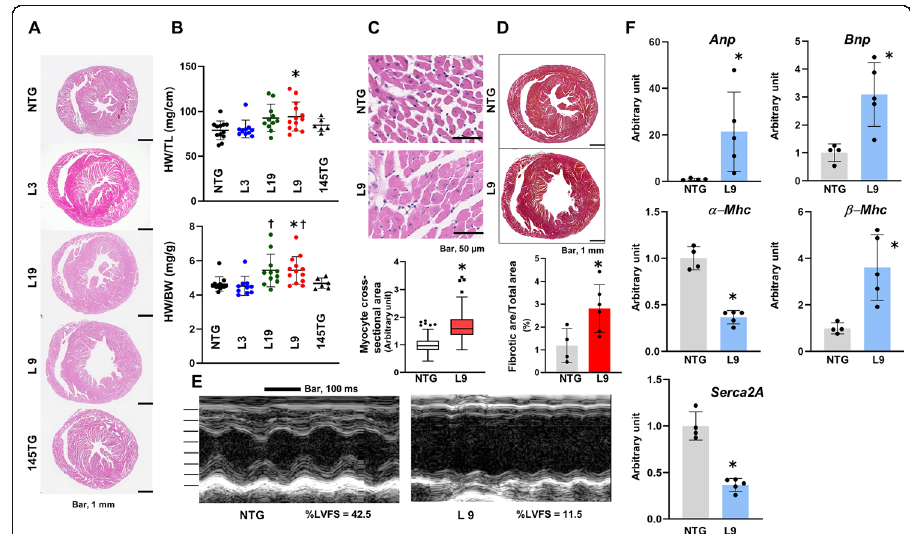
Fig. 2 Characterization of the hearts in α MHC/miR-143/145TG and α MHC/miR-145TG mice. a Macroscopic histological analysis of hematoxylin & eosin-stained hearts of 4-month old male α MHC/miR-143/145TG and α MHC/miR-145 TG mice. b Heart weight corrected for tibia length (upper panel) or body weight (lower panel) of male α MHC/miR-143/145TG and α MHC/miR-145TG mice. The results are presented as the means ± SD with scattered blots. Significance was assessed with one-way ANOVA followed by a post hoc Tukey test ( n = 6 ~ 13; * p < 0.05 vs. NTG, † p < 0.05 vs. L3). c Microscopic histological analysis of hematoxylin & eosin-stained hearts of 4-month old male L9 mice. The lower panel shows the quantitative analysis of the myocyte cross-sectional area. We analyzed 316 cardiomyocytes of four L9 mice at 4 months of age and 292 cardiomyocytes of three NTG mice. Data are presented as box and whisker plots with the Tukey method and unpaired t -test applied (* p < 0.05 vs. NTG). d Macroscopic histological analysis of Masson-trichrome- stained hearts of 4-month old male L9 mice. The lower panel shows the quantitative analysis for the fibrotic area. The results are presented as the means ± SD with the unpaired t -test applied to determine significance ( n = 4 ~ 6; * p < 0.05 vs. NTG). e Representative M-mode echocardiography of a 3-month old male L9 mouse. The interval of each scale bar of the Y-axis is 1 mm. %LVFS: percentage left ventricular fractional shortening. f Quantitative RT-PCR analysis of molecules correlating with cardiac remolding of 3- month old male L9 mice. The results are presented as the means ± SD with the unpaired t -test applied to determine significance ( n = 4 ~ 5; * P < 0.05 vs. NTG). Similar results were obtained in at least